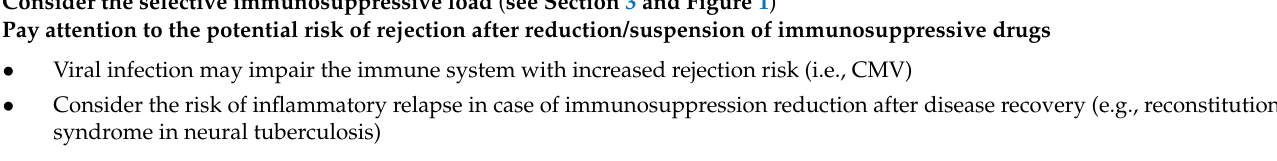
inhibitors. This figure was created with BioRender.com.